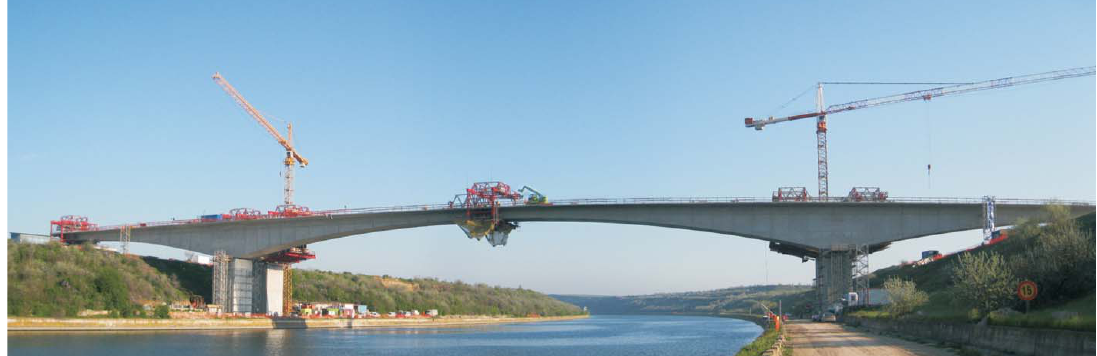
Figure 11. Picture of the bridge during its